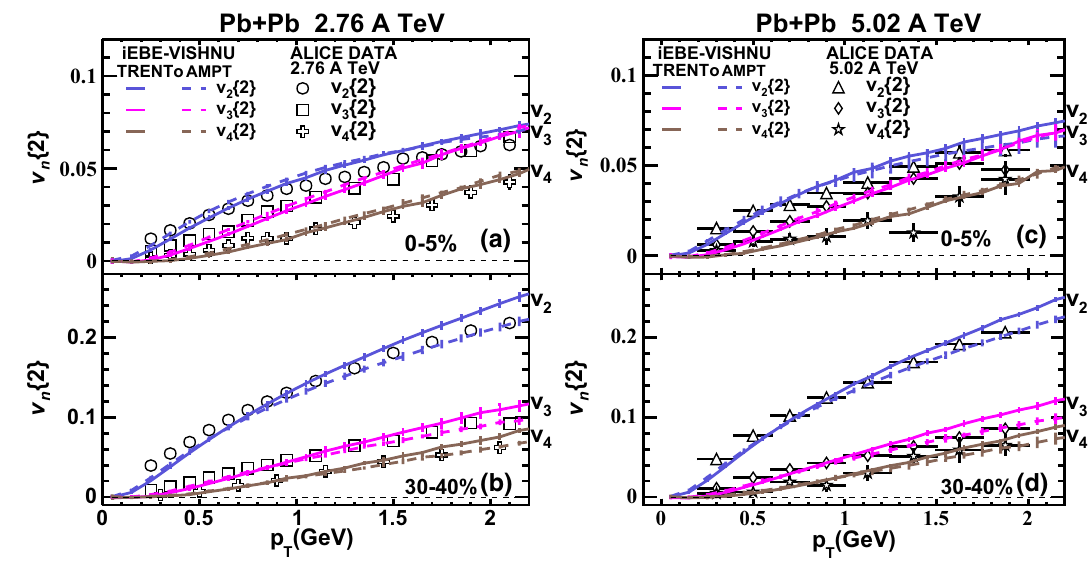
Fig. 5 The differential flow harmonics v n ( p T ) ( n = 2–4) of all charged hadrons in 0–5 and 30–40% Pb + Pb collisions at 2.76 A TeV (left panels) and 5.02 A TeV (right panels), calculated from iEBE-VISHNU with TRENTo and AMPT initial conditions. The experimental data are taken from [20,52],